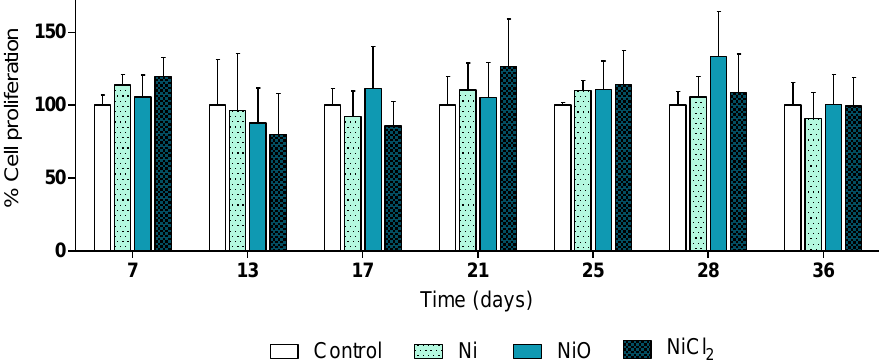
Figure 2. Human lung cells (BEAS-2B) were exposed to Ni NPs, NiO NPs and NiCl 2 (0.5 µg/mL) for 6 weeks. At the indicated time-points Alamar Blue proliferation assay was performed. Results are presented as mean values ± S.D.